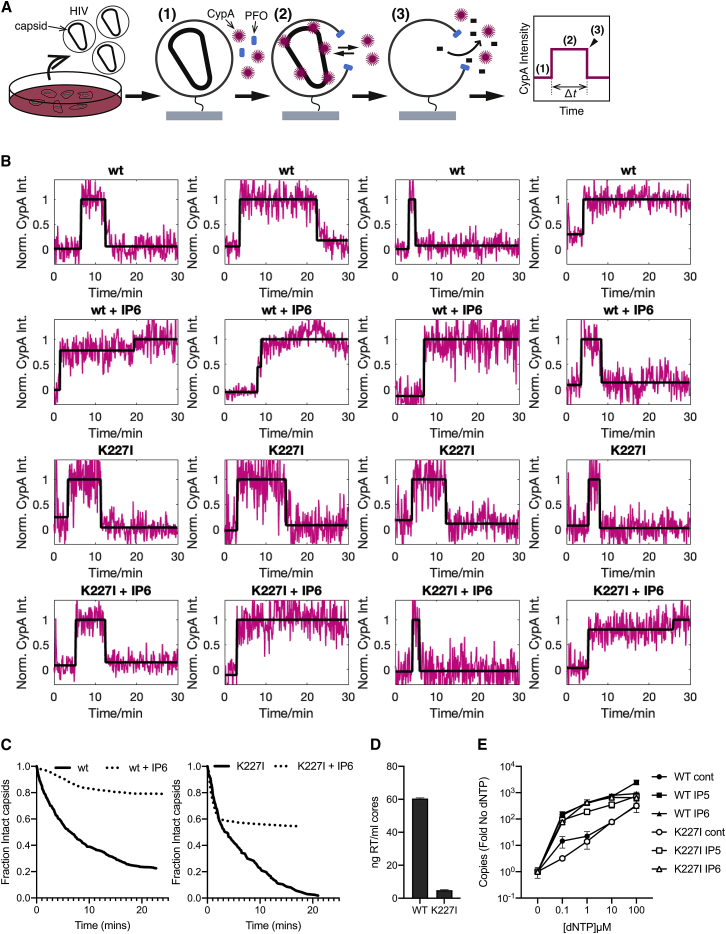
Addition of IP6 Is Able to Stabilize Both WT and K227I Mutant Virions(A) Outline of single-molecule analysis for virus stability. Briefly, viral particles were immobilized, and fluorescence traces were obtained at the locations of individual virions while permeabilizing their membranes with PFO in the presence of fluorescently labeled CypA (1). CypA binds to the capsid, resulting in the appearance of a stable fluorescence signal (2). As the capsid uncoats, the CypA signal disappears (3), and the fluorescence trace returns to background levels.(B) Example traces for individual virions demonstrating the tracking of fluorescence over time. Addition of IP6 to the virions results in a delay in the fluorescence signal reduction signaling uncoating.(C) Capsid survival curves collated from single-virion traces showing that K227I particles have a high fraction of short-lived capsids in the presence and absence of IP6, while the remainder of capsids is strongly stabilized by IP6 addition for both wild-type and K227I particles.(D) Capsid core yields determined by RT quantification (representative of at least two independent experiments).(E) ERT assay using cores isolated from WT and K227I virions, showing a dNTP titration in the absence of IPs or in the presence of either IP5 or IP6. Both WT and K227I cores are competent for ERT and are stabilized by both IP5 and IP6 to the same extent. Data are average of three biological replicas and have been normalized to the copies of RU5 measured in the absence of dNTPs.